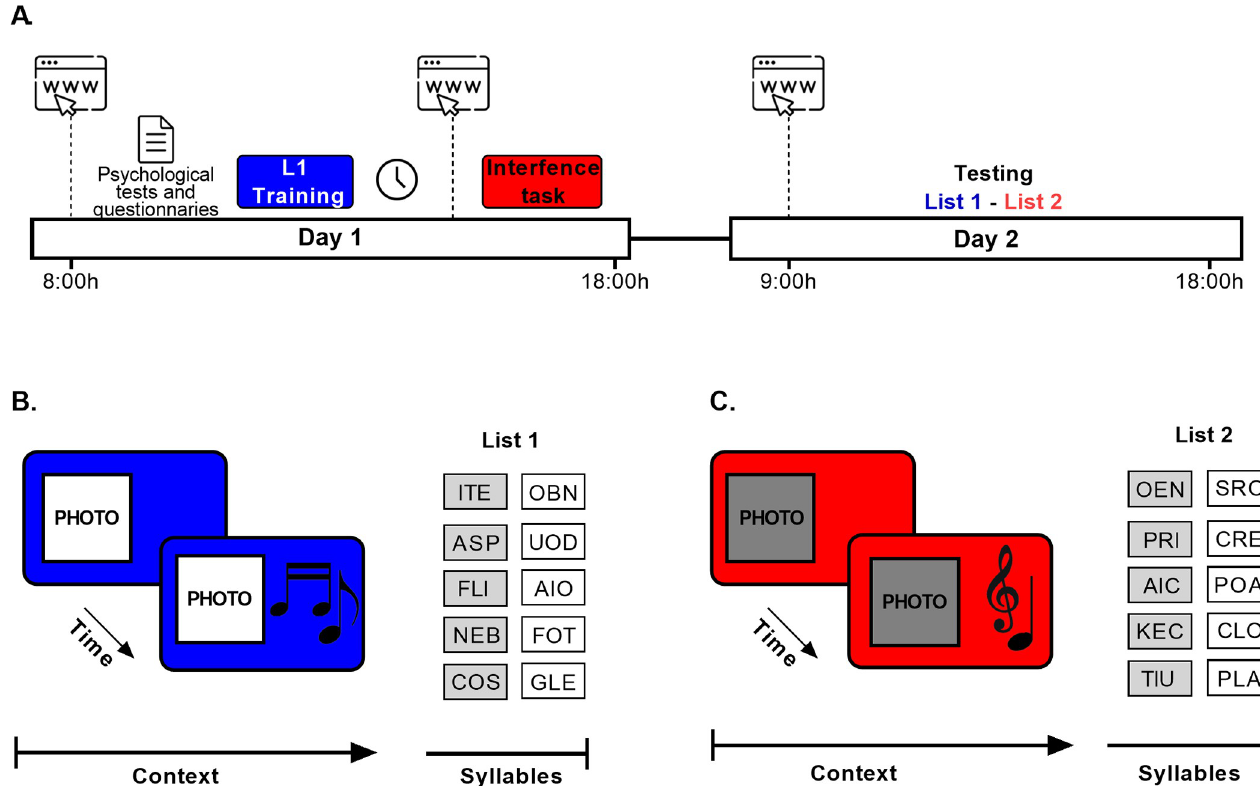
Fig 1. Experimental design and memory task. (A) Protocol. On day 1, the participants started the experiment between 9:00 h and 18:00 h. First, they gave their informed consent, filled out a personal data questionnaire and completed the psychological tests and questionnaires (Beck Depression Inventory II, State- Trait Anxiety Inventory, Pittsburgh Sleep Quality Index and Morningness-Eveningness Questionnaire). Next, all the experimental groups received the List 1 training. The groups differed in the moment they received the interference task (5 min, 30 min, 3 h or 8 h after List 1 training). On day 2, at 48 h on day 1, all groups received an email at 9:00 h with the link to re-enter the platform and performed the last session of the experiment. They could enter the link at any time between 9:00 h and 18:00 h. The experimental groups were tested for retrieval on both lists: First for List 1 and then for List 2, while the control groups were only tested on the single list. (B). List 1 Training. The training session consisted of 10 trials. Each trial started with the presentation of the blue background and image of an Italian coast for 4 sec, followed by the same stimuli accompanied by the tarantella music for another 4 sec. After that, the five pairs of cue-response syllables (List 1) were presented successively and in random order. (C). Interference task. The training of the interfering task was the same as in B but with a different context (red background color, the image of a forest and classical music) and different five pairs cue-response syllables (List